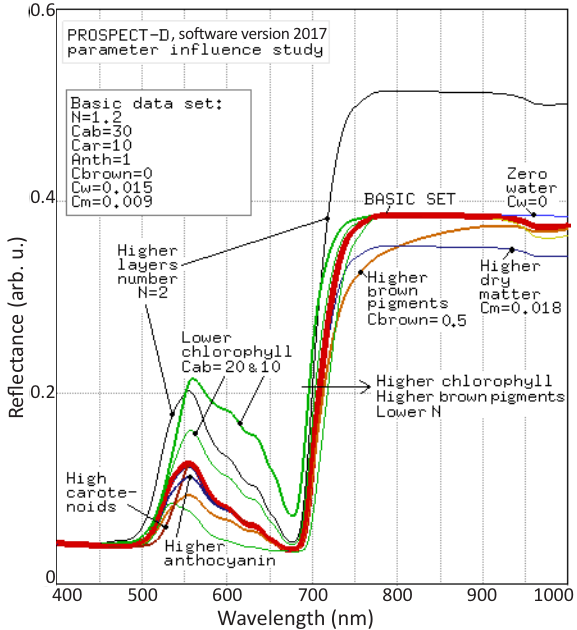
Fig. 2. Study of biophysical factor influences on the green vegetation reflectance spectra with the state­of­the­art leaf level biophysical model PROSPECT­D version 6.0